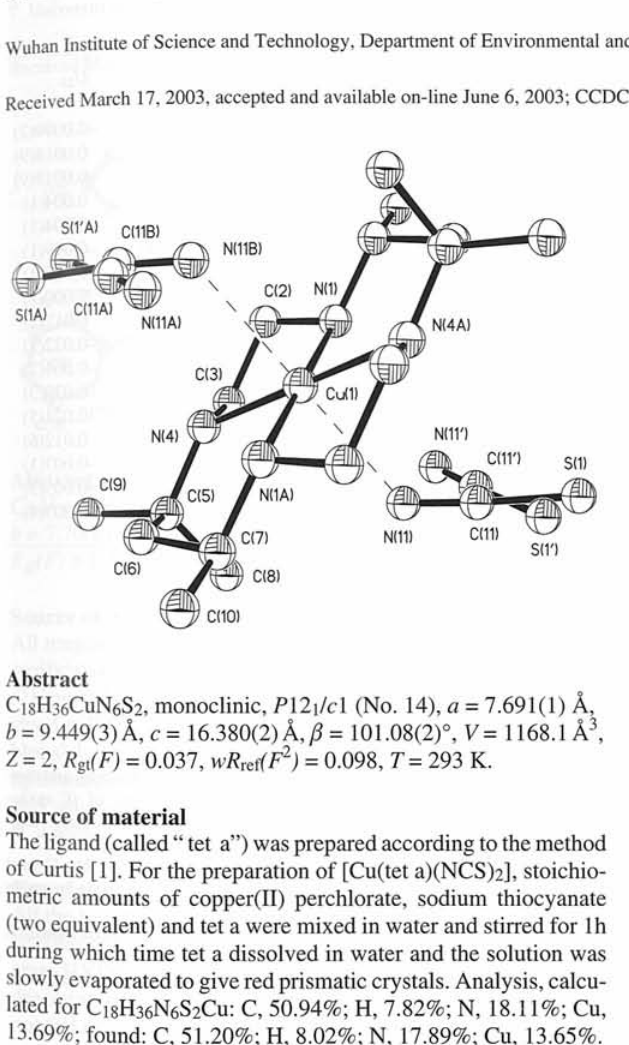
Table 2. Atomic coordinates and displacement parameters (in